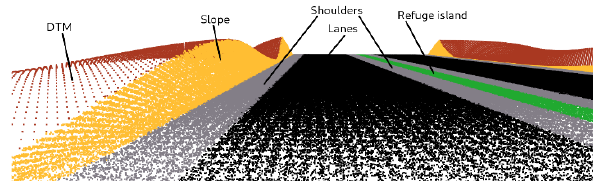
Figure 2. Simplified view of a Highway point cloud and its